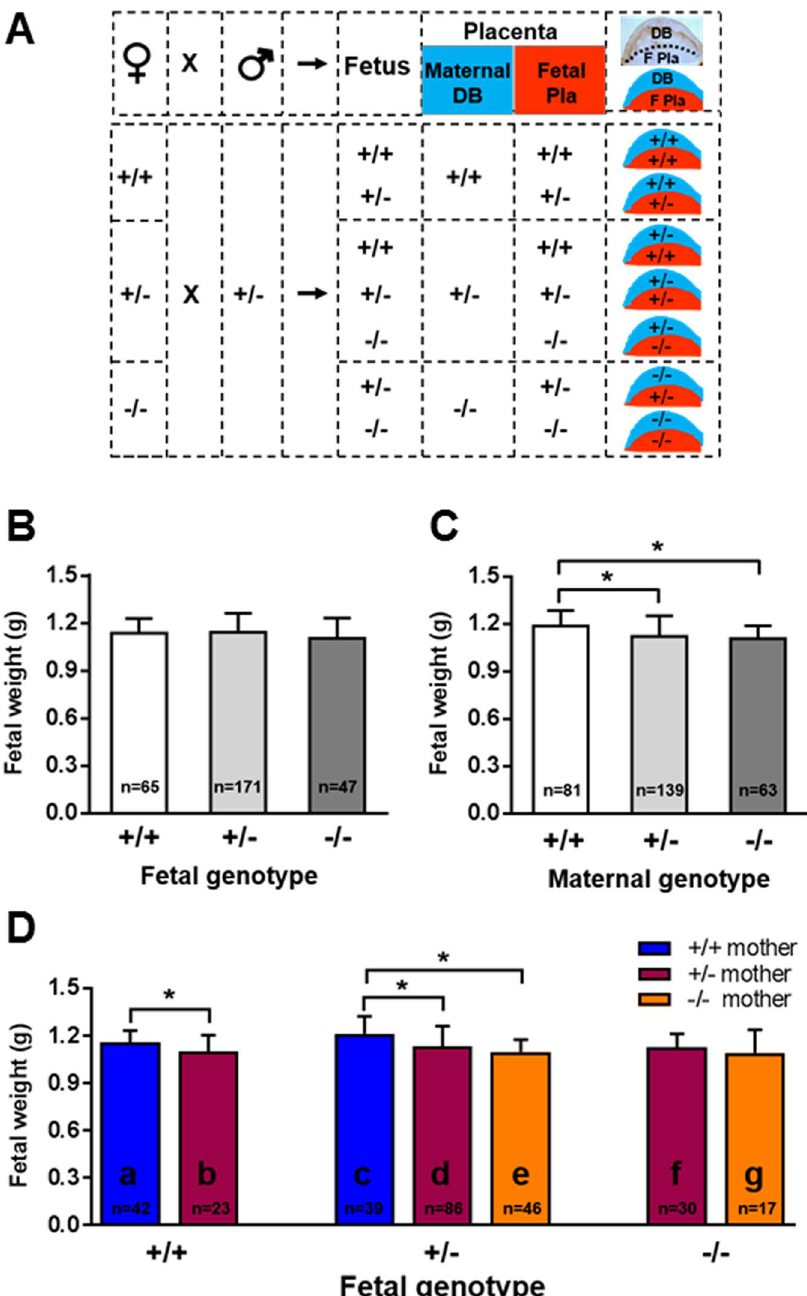
Figure 2. The impact of HtrA3 gene deletion in the mother versus fetus on E18 fetal weight. ( A ) The mating scheme to analyze the maternal and fetal contribution to the genomic makeup of the placenta. The top row illustrates that when a female ( ♀ ) is mated to a male ( ♂ ) mouse, the resulting fetus and placenta will be genetically related but not identical. The mouse placenta is comprised of maternal decidua basalis (DB) and fetal placenta (F Pla), genetically the maternal component will be identical to the mother, whereas the fetal component will be similar to the fetus. An actual image of a d10.5 placental section is shown at the far right top corner, displaying the maternal DB on the top (stained for desmin in brown) and the F Pla on the bottom. Immediately below it is a schematic drawing of the placenta, showing the maternal DB on the top in blue and F Pla on the bottom in red. The lower section of the figure shows the scheme for mating female mice of three HtrA3 genotypes ( + / + , + / − or − / − ) with males of HtrA3 heterozygous ( + / − ) to generate three HtrA3 genotypes ( + / + , + / − or − / − ) of fetuses but seven genotypes of placentas. Each placental type is schematically drawn to show the HtrA3 genotype of the maternal DB (top in blue) and the F Pla (bottom in red). ( B – D ) Fetal weight at E18. Data were analyzed according to the genotype of the fetus ( B ), the mother ( C ), and the fetus as well as the mother ( D ). The number of fetuses examined for each group is shown on the graph. The 7 distinctive groups in ( D ) are labeled as “a, b, c, d, e, f, g” respectively, and this labelling system is consistently applied to other figures. Data are expressed as mean ± SD. * p <